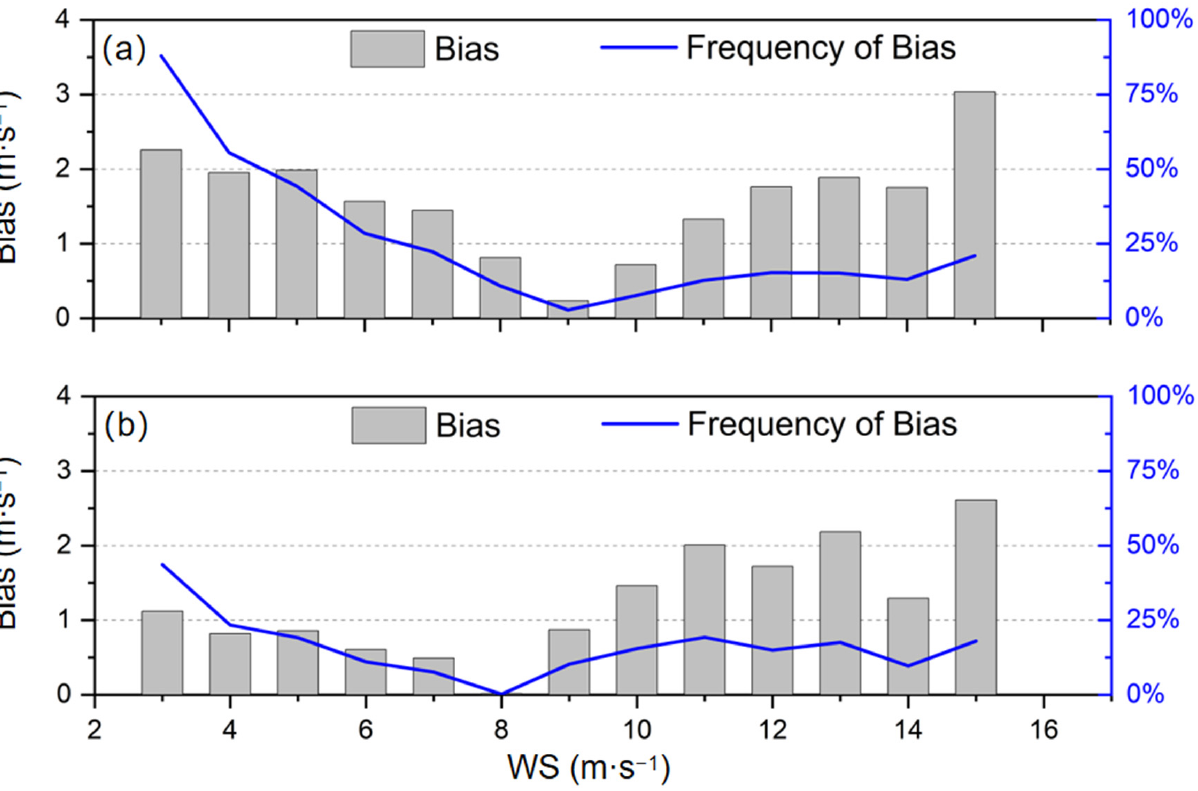
Figure 7. Comparison of simulation deviations in different wind speed ranges after nearest replace- ment ( a ) before correction and ( b ) after correction.